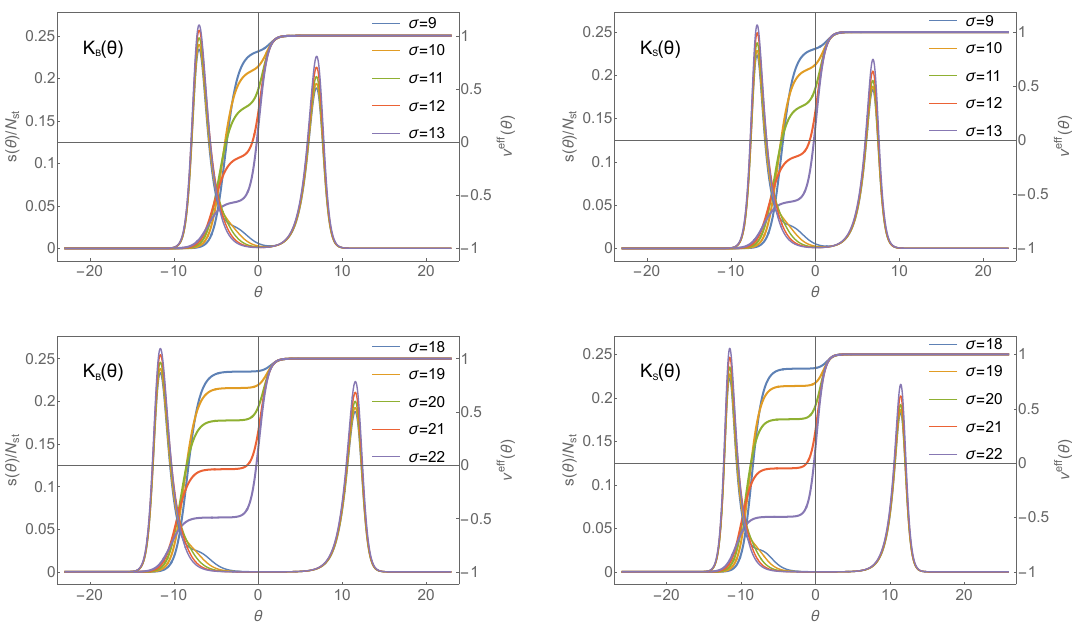
Figure 10 . The (normalised) spectral steady-state entropy density s p θ q{ N st P r 0 , 0 . 25 s (left axis in each panel) and the effective velocity v eff p θ q P r´ 1 , 1 s (right axis) for fixed injected energy densities and various σ parameters near the local minimum of the production rates. We have 2 log 2 { β 13 . 005 for the left figures and 2 log 2 { β 22 . 215 for the right FF “ FF “